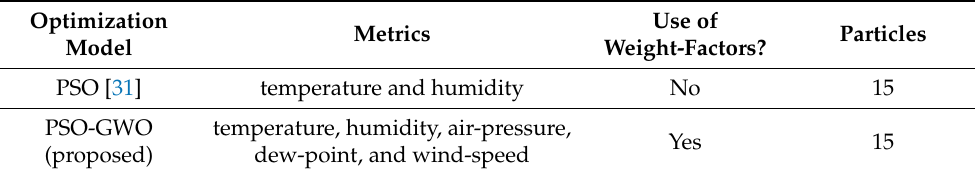
Table 8. Different model configurations used for comparison.